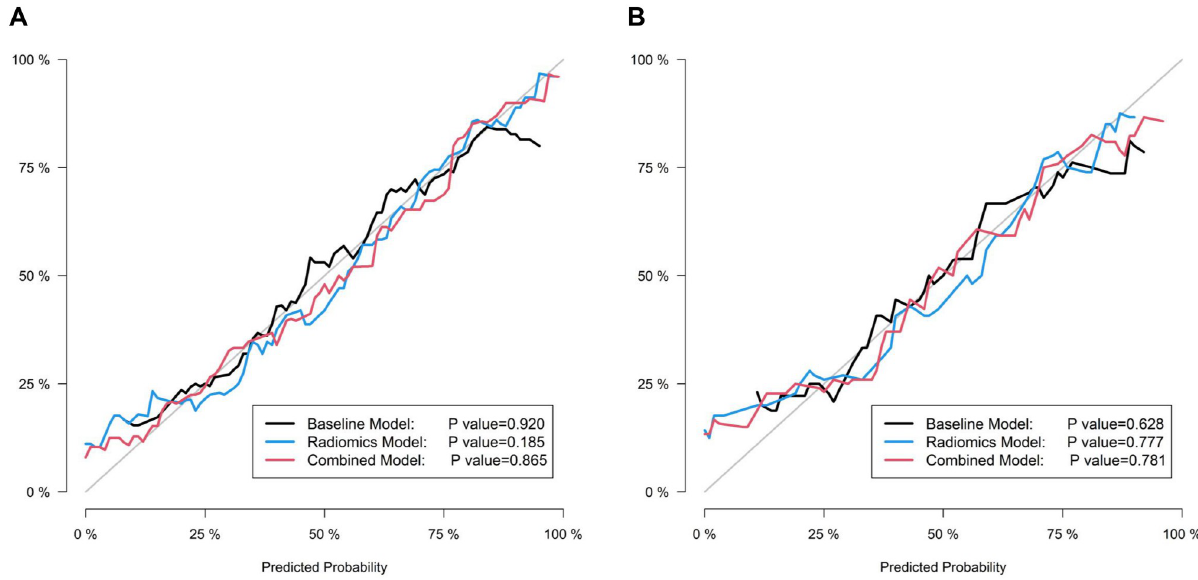
Fig 4. Calibration curves of the three models for the training (A) and test (B) cohorts.